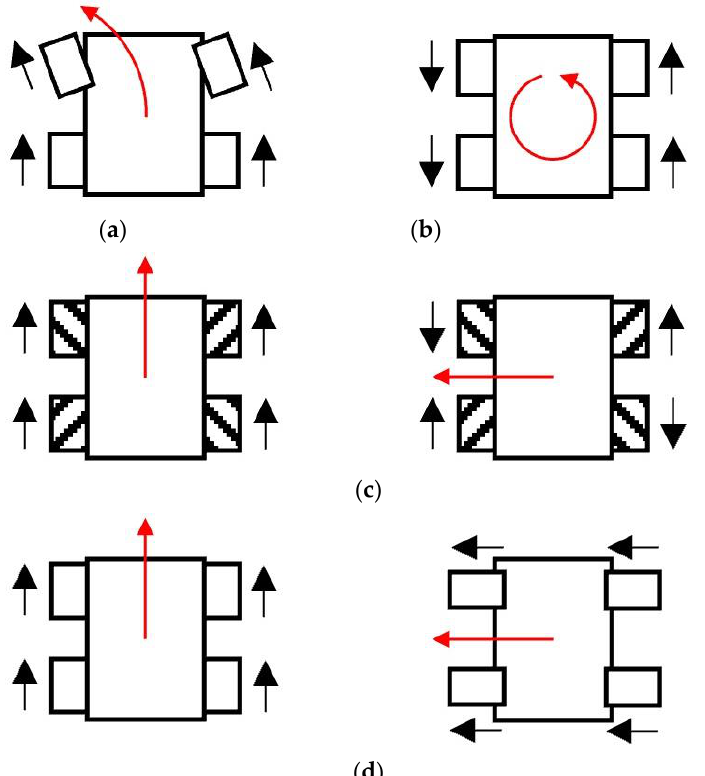
Figure 4. Four methods for making a left turn. The black arrow indicates the direction of the moving wheel, and the red arrow indicates the direction of the robot as a result of the moving wheels. ( a ) two-wheel steering; ( b ) skid steering; ( c ) Mecanum wheels (straight and side movement); ( d ) four-wheel steering (straight and side movement).